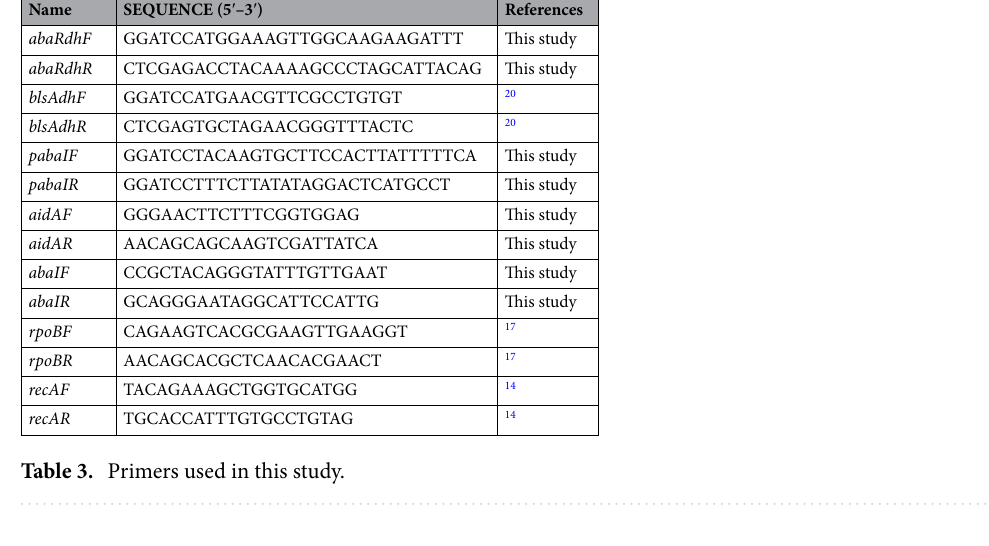
Table 2. Luria–Bertani (LB) broth (Difco) and agar (Difco) were used to grow and maintain bacterial strains. Broth cultures were incubated at the indicated temperatures either statically or with shaking at 200 rpm.